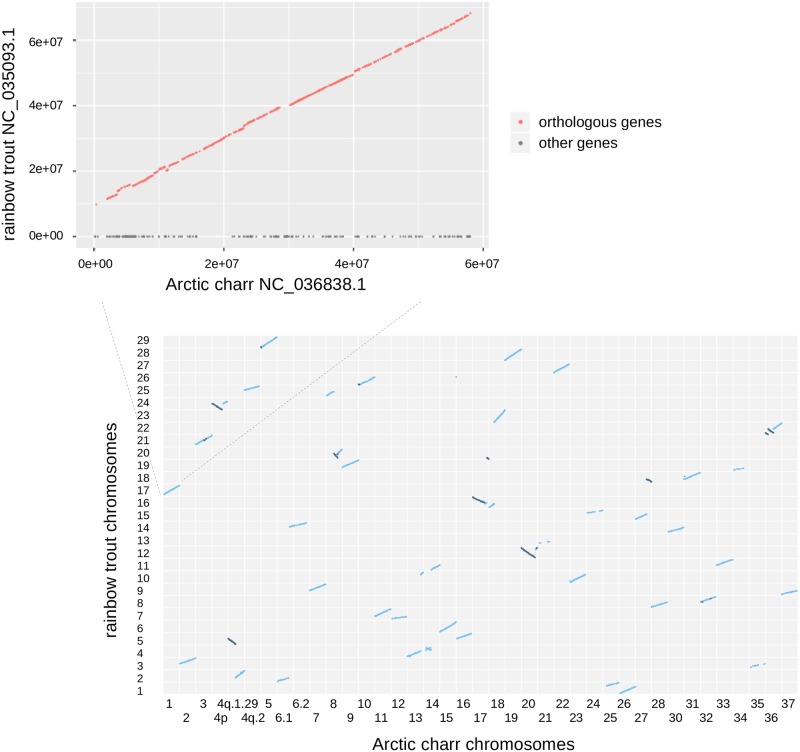
Example of homologous chromosomes and orthologs between species.Linear alignments between the rainbow trout and Arctic charr genome assembliess are shown in the bottom graph. The rainbow trout chromosomes correspond to the NCBI RefSeq accession from the lowest number to highest. Identified orthologous genes are plotted with their relative positions on the rainbow trout and Arctic charr chromosomes on the top graph. Genes without a known ortholog are plotted in gray.